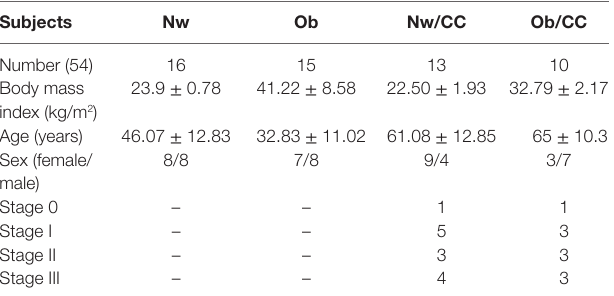
TaBle 1 | Anthropometric and clinical parameters of study subjects.